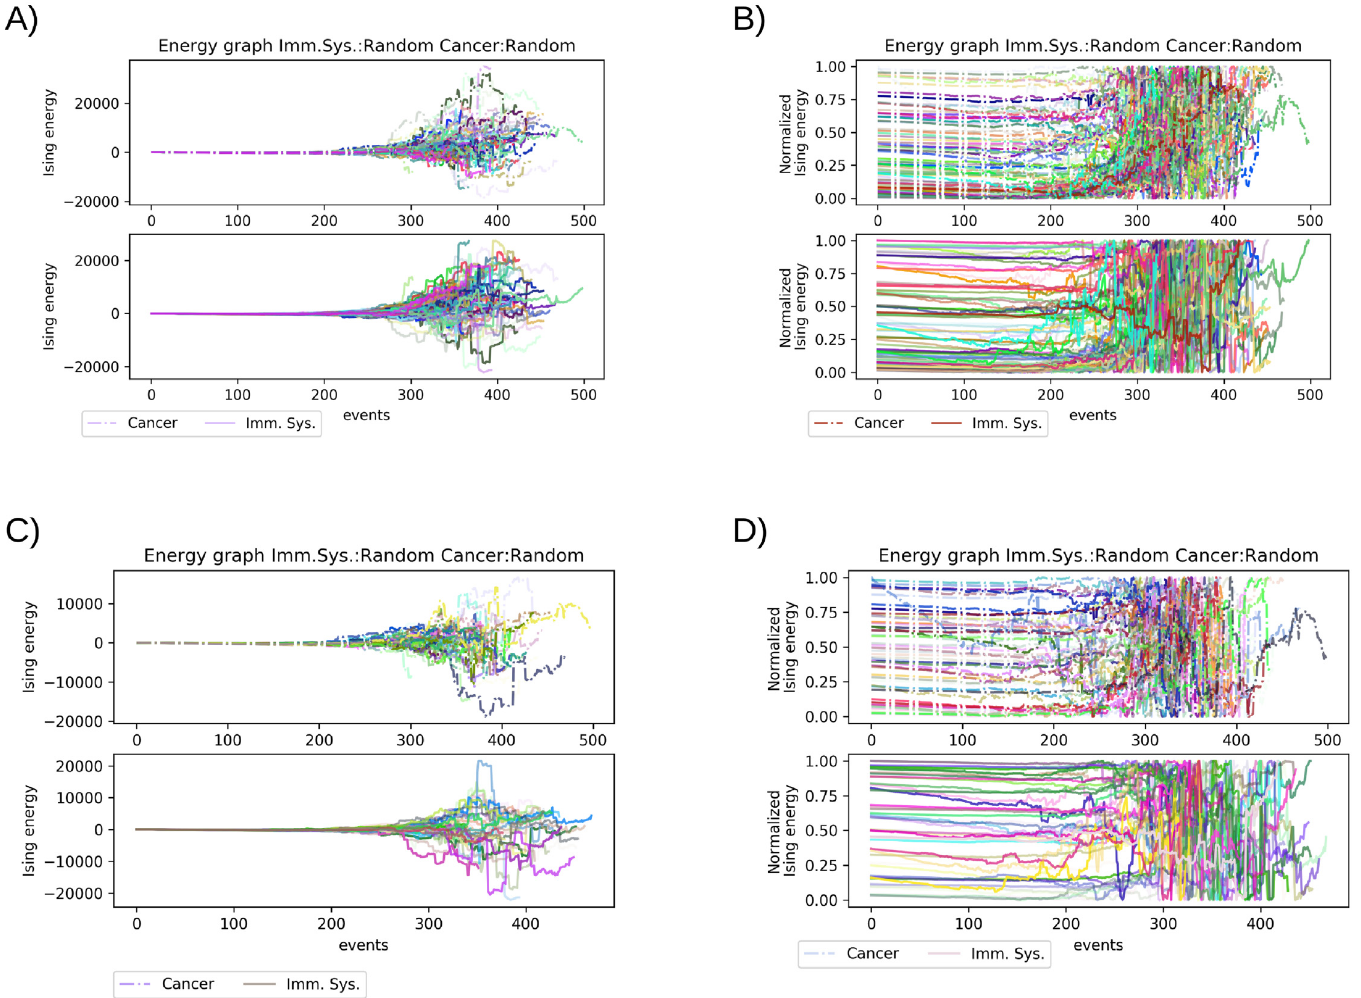
Fig 2. Comparison of the random vs. random scenario. A) A plot of the Ising energy of all the simulations put together. B) Normalized Ising Energy of all the simulations show in A. C) The upper panels show only the simulations won by the cancer cells and the lower panel show only the simulation won by the immune system. D) Normalized Ising energy of the simulation displayed in C in the same order upper panel corresponds to simulation won by the cancer cells, and the lower panel simulation won by the immune system.